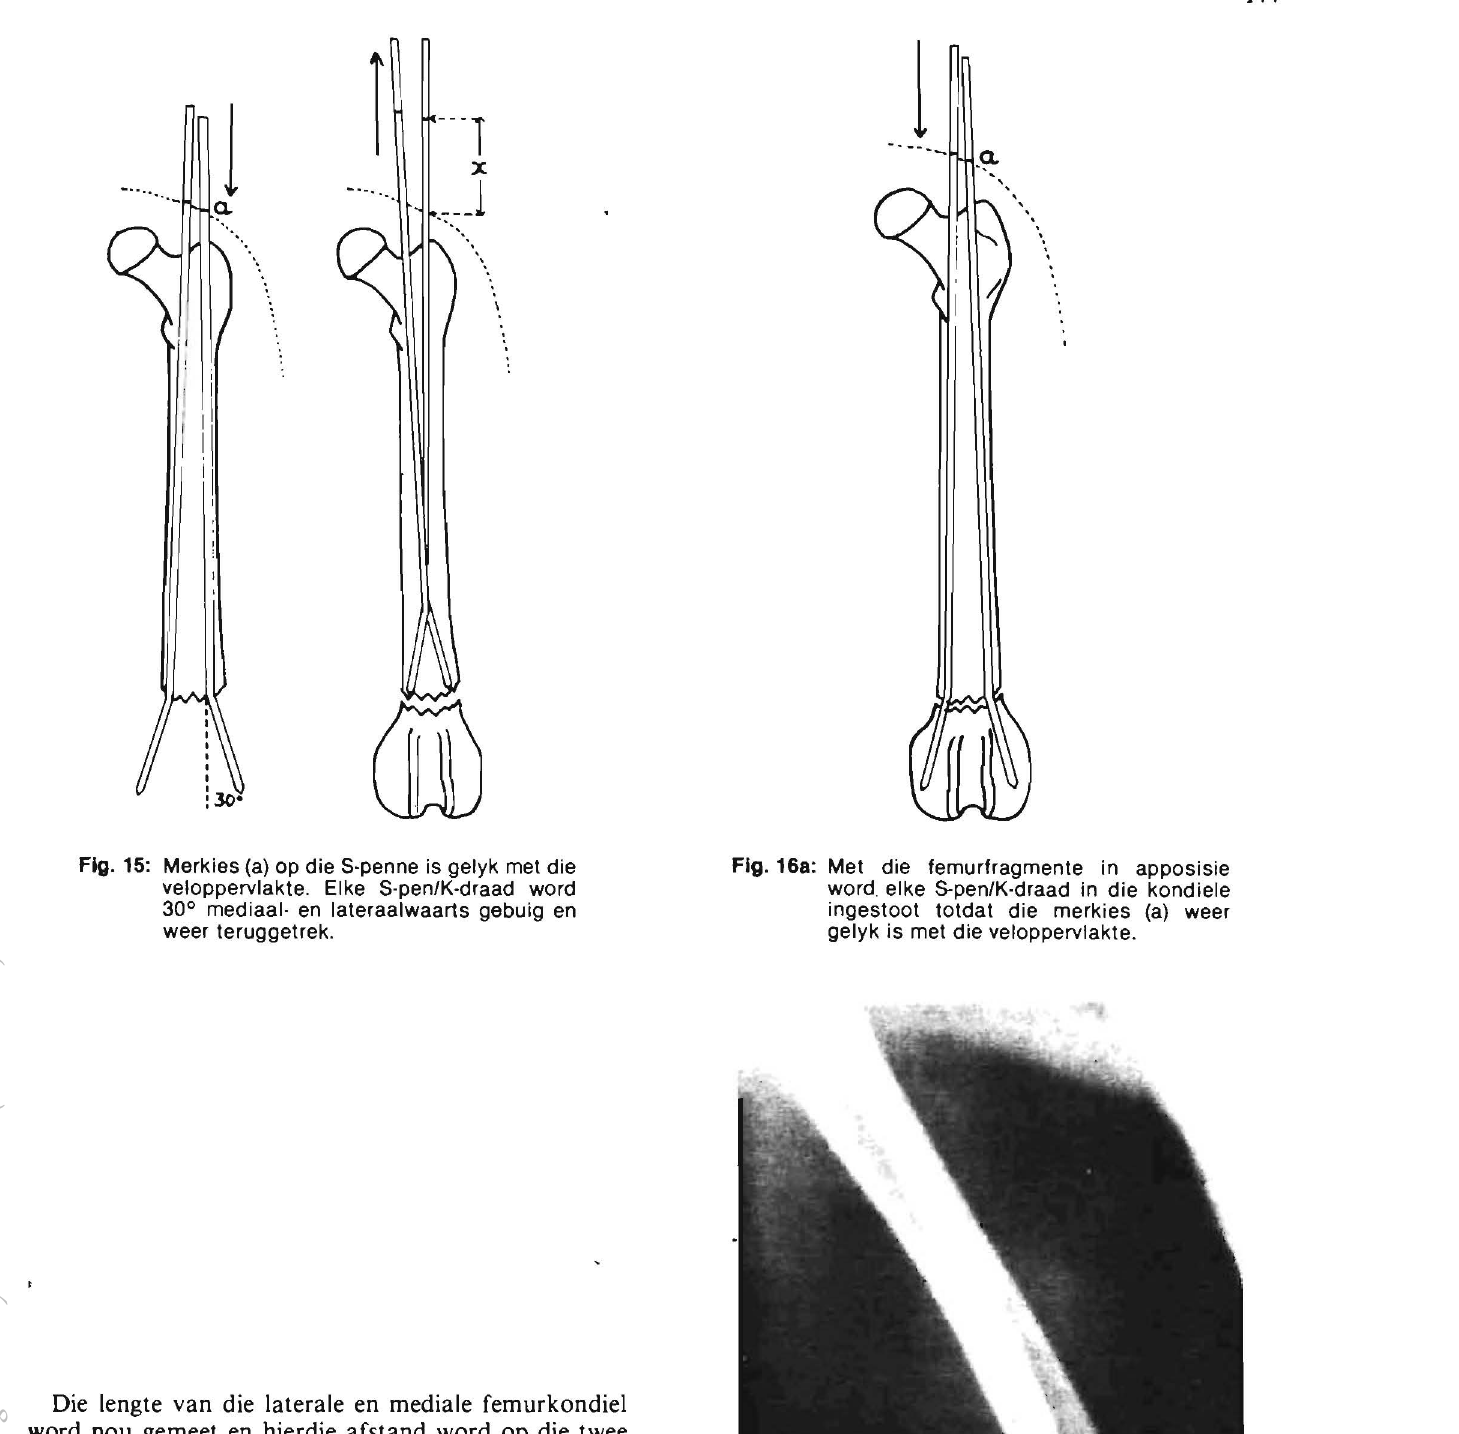
Fig. 168: Met die femurfragmente in apposisle word. elke S.pen/K·draad in die kondiele